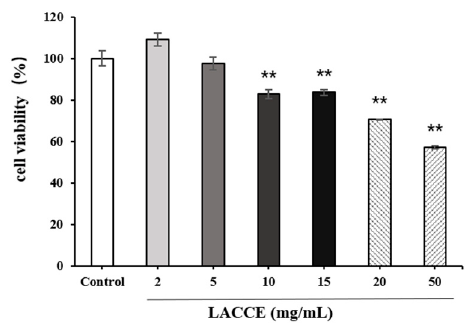
Figure 5. Effects of different concentrations of Leontopodium alpinum callus culture extract (LACCE) on HFF cell viability. The data are expressed as mean ± standard deviation (SD) of three independent experiments ( n = 3). The data were analyzed using one-way analysis of variance (ANOVA) followed by Tukey’s test. ** p < 0.05, versus cells without LACCE treatment.